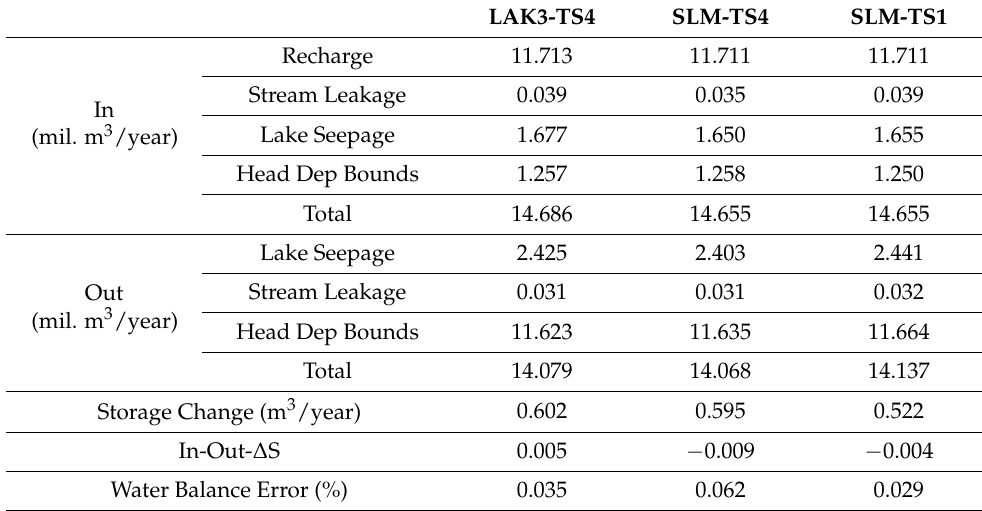
Table 2. Water balance for the groundwater in